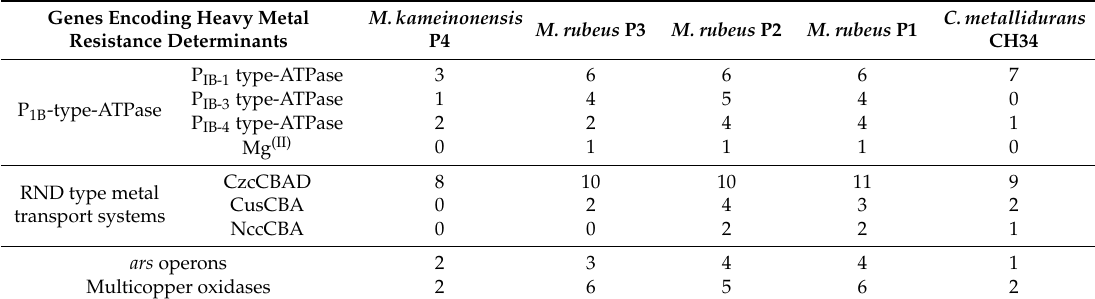
Table 4. Heavy metal related genes in the analyzed Mucilaginibacter strains in comparison to Cupriavidus metallidurans